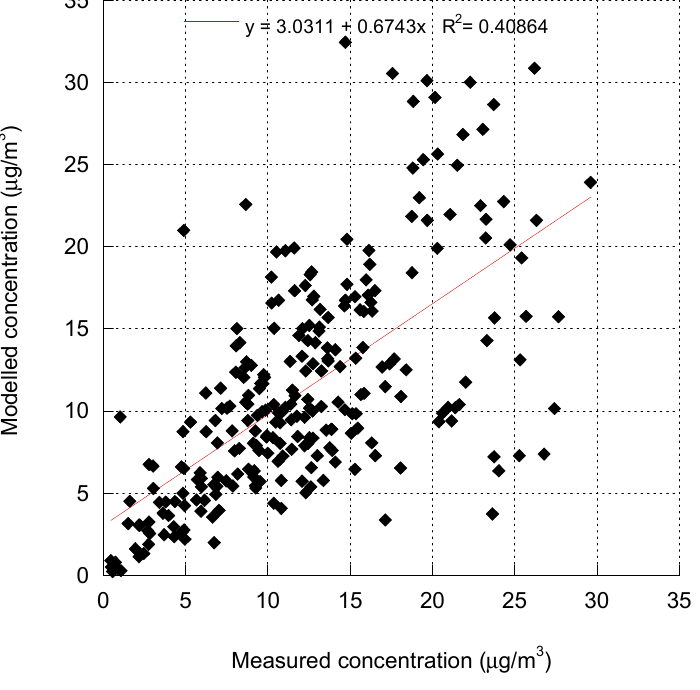
Figure 3. Comparison of modeled and measured annual mean NO (µg/m 3 ) at AIRBASE stations in 2005 ( top ), as well as annual mean NO (10 15 mlc·cm − 2 ) ( bottom